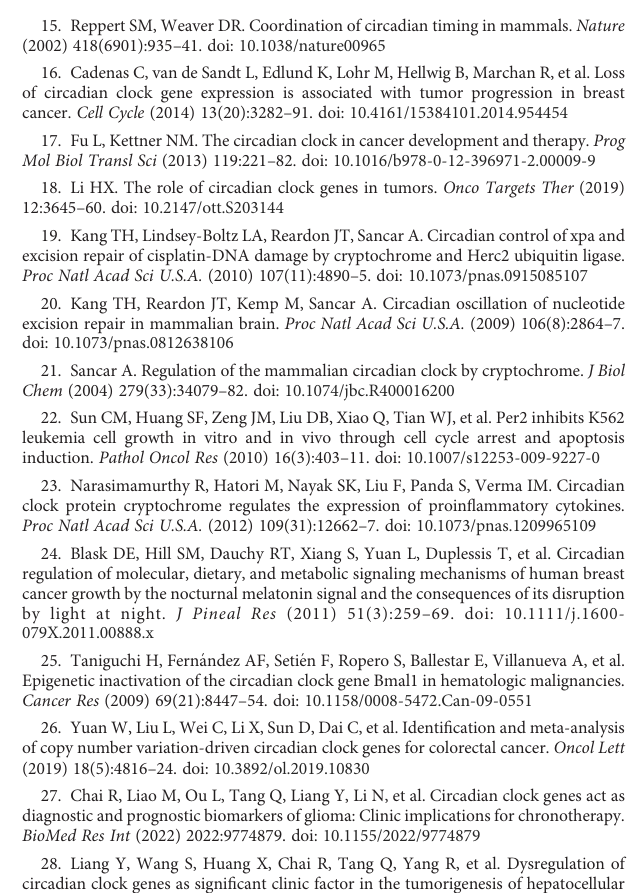
SUPPLEMENTARY TABLE 1 1424 CRRGs were obtained through Genecards database. SUPPLEMENTARY TABLE 2 Differential expression analysis of CRRGs in HNSCC and normal